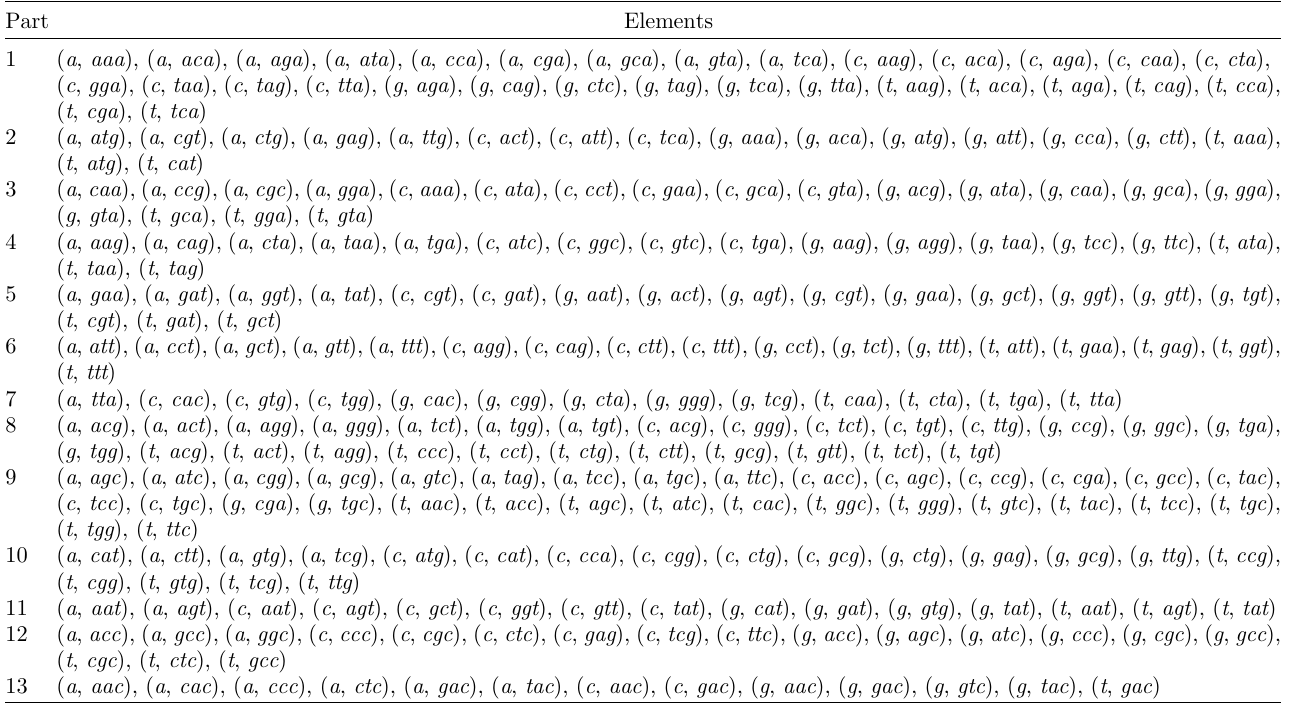
Table 7. Part composition for the model – (ii) with o = 3 and G = 9, see Table 6. Part Elements